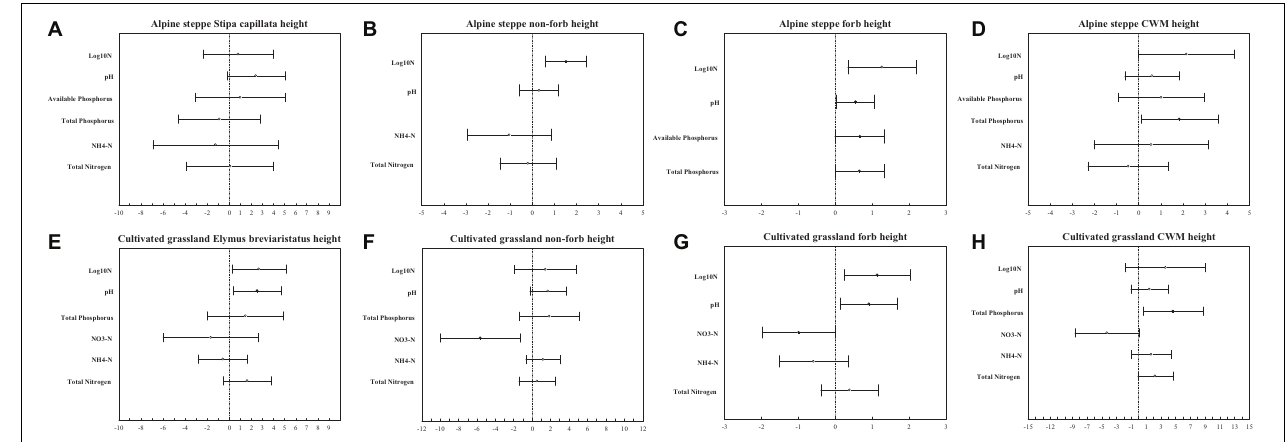
FIGURE 2 | Standardized parameter estimates ( ± 2 SE) of log 10 nitrogen addition gradients, pH, available phosphorus, total phosphorus NH 4 -N, NO 3 -N, and total nitrogen for Stipa capillata height (A) , non-forb height of alpine steppe (B) , forb height of alpine steppe (C) , community weighted mean value of height of alpine steppe (D) , Elymus breviaristatus height (E) , non-forb height of cultivated grassland (F) , forb height of cultivated grassland (G) , and community-weighted mean value of height of cultivated grassland (H) . Filled circles indicate significant effects ( p < 0.05).